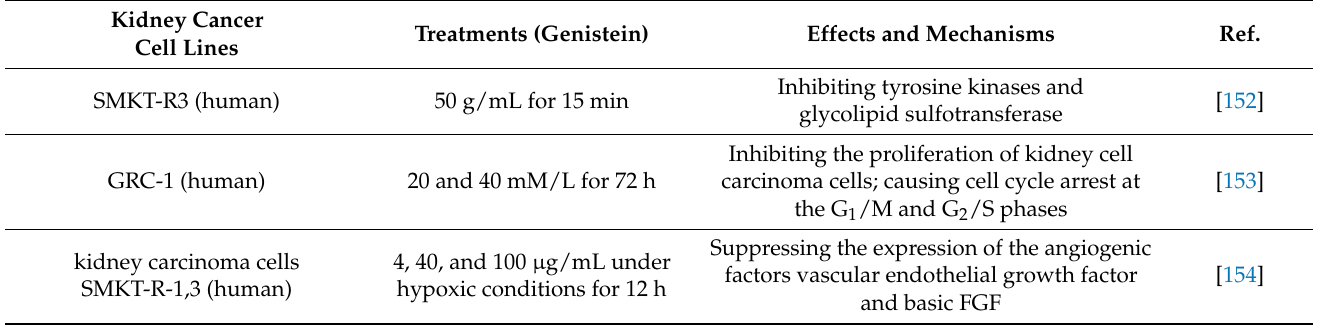
Table 3. The effects of genistein attenuating kidney cancer